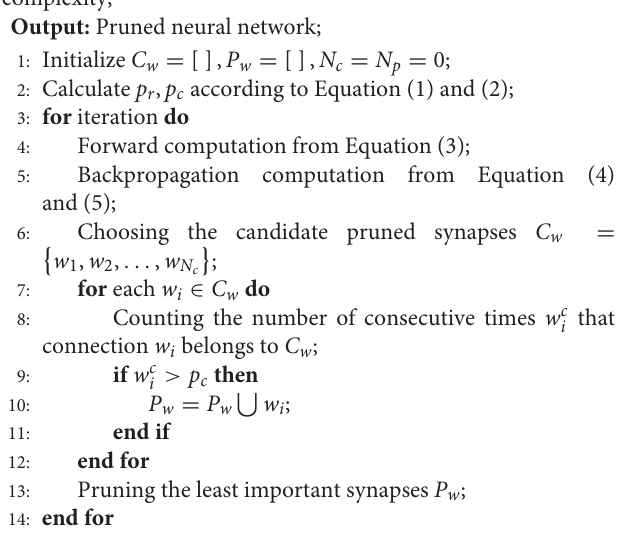
Algorithm 1 : The BSP